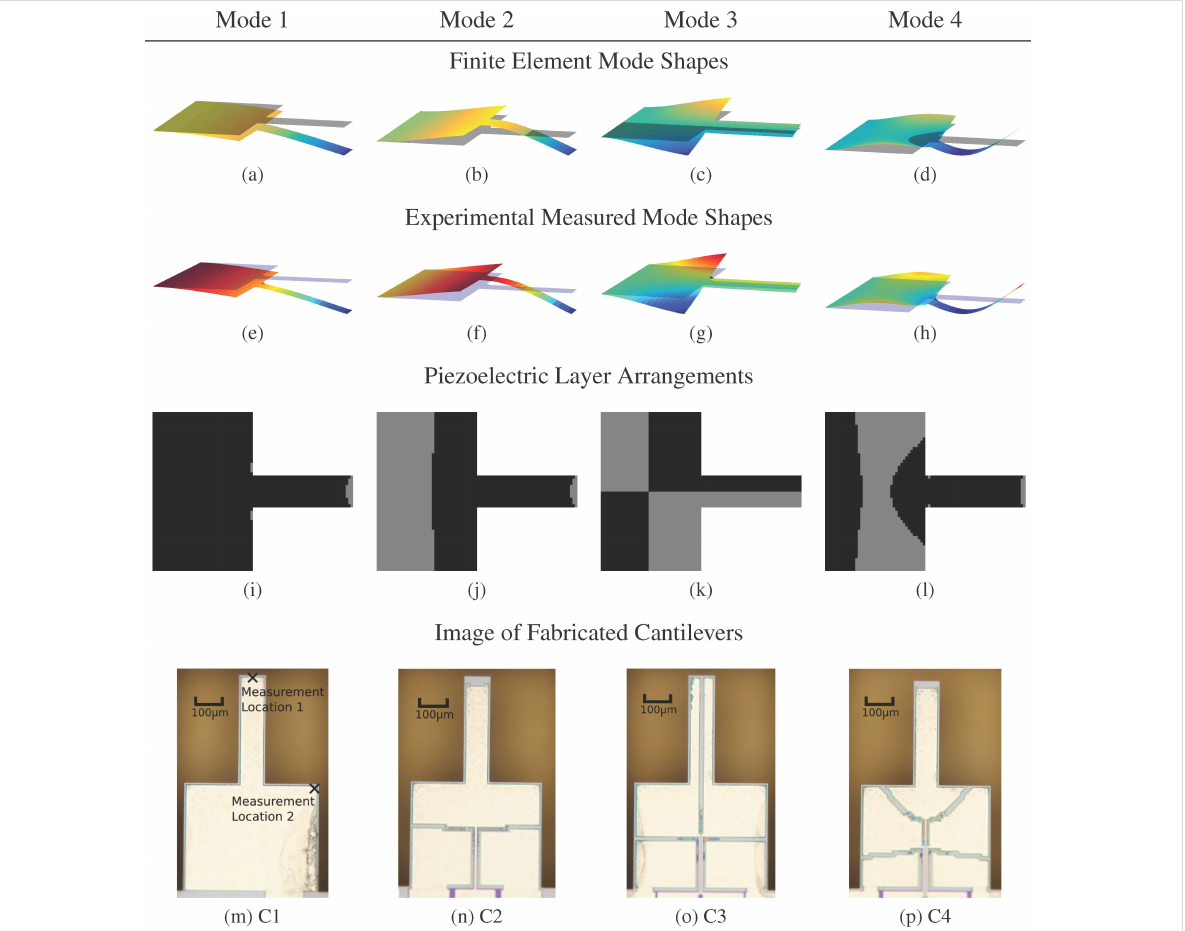
Figure 2: (a)–(d) The first four mode shapes of the cantilever from the FE model. (e)–(f) The modes measured using a laser vibrometer (Polytec MSA-400). (i)–(l) The piezoelectric arrangement to maximize the response of the transducer to each mode. The gray electrodes induce a charge in the opposite polarity to the black electrodes. (m)–(p) The fabricated cantilever